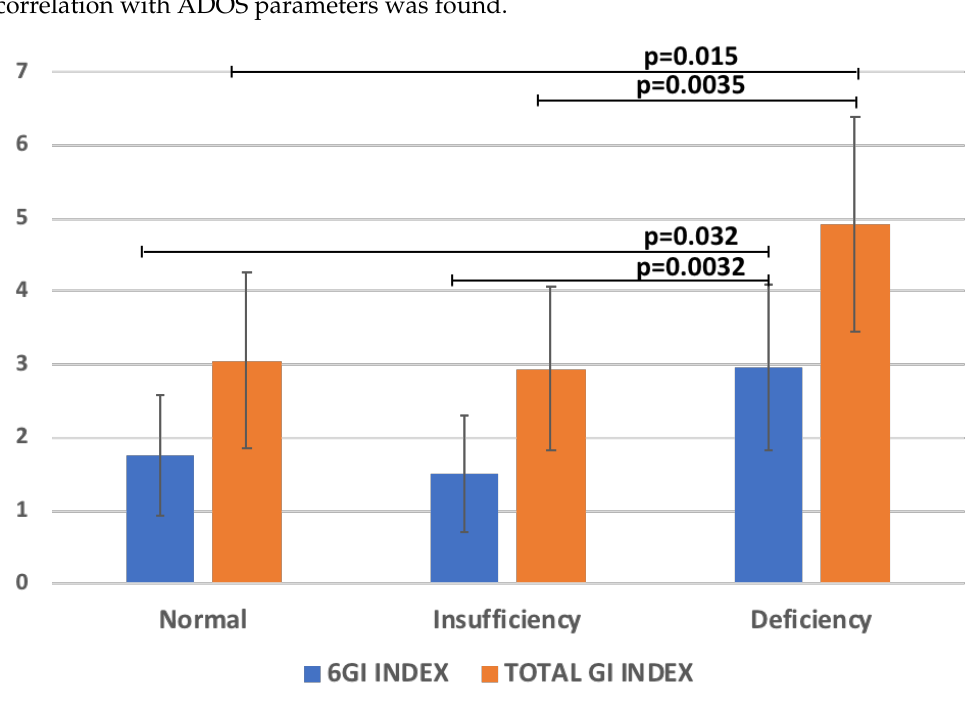
Figure 2. The scores of 6GI-Index and Total GI-Index vs 25(OH)D categories (normal levels ≥ 30, insufficient 21 – 29, deficient <20 ng/mL [20]. insufficient 21–29, deficient <20 ng/mL